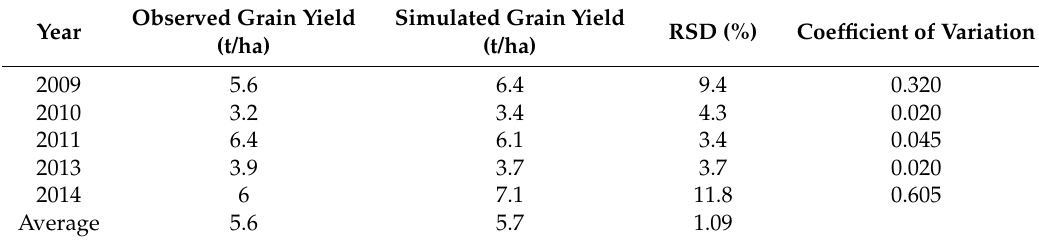
Table 6. Validation of the model.